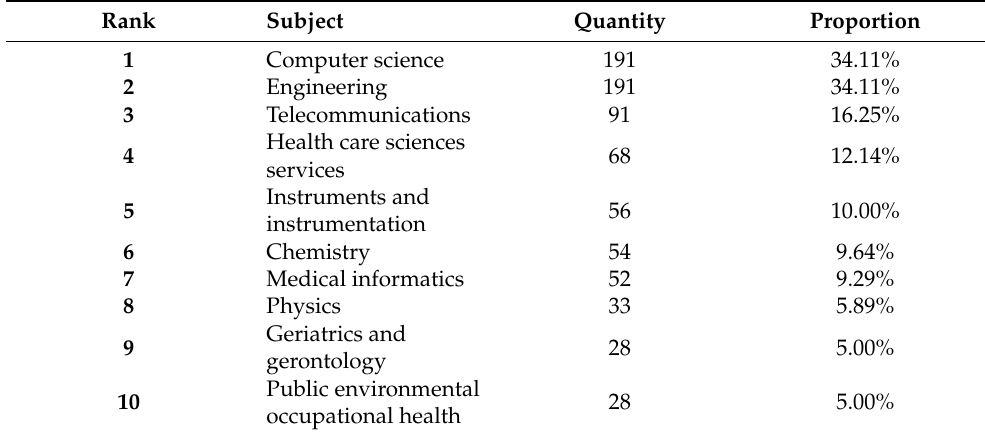
Table 2. The distribution of the top 10 subjects of the studies from